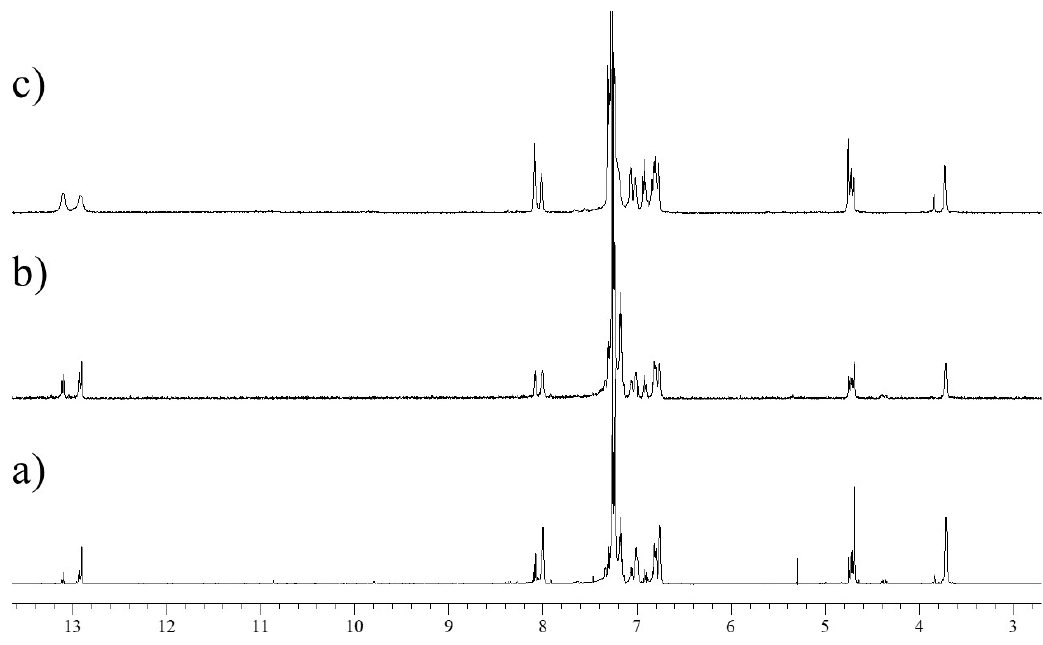
Figure 4. 1 H NMR spectra in CDCl 3 of: ( a ) Oligo–Salen–A; ( b ) Oligo–Salen–B; ( c ) Oligo–Salen–C.